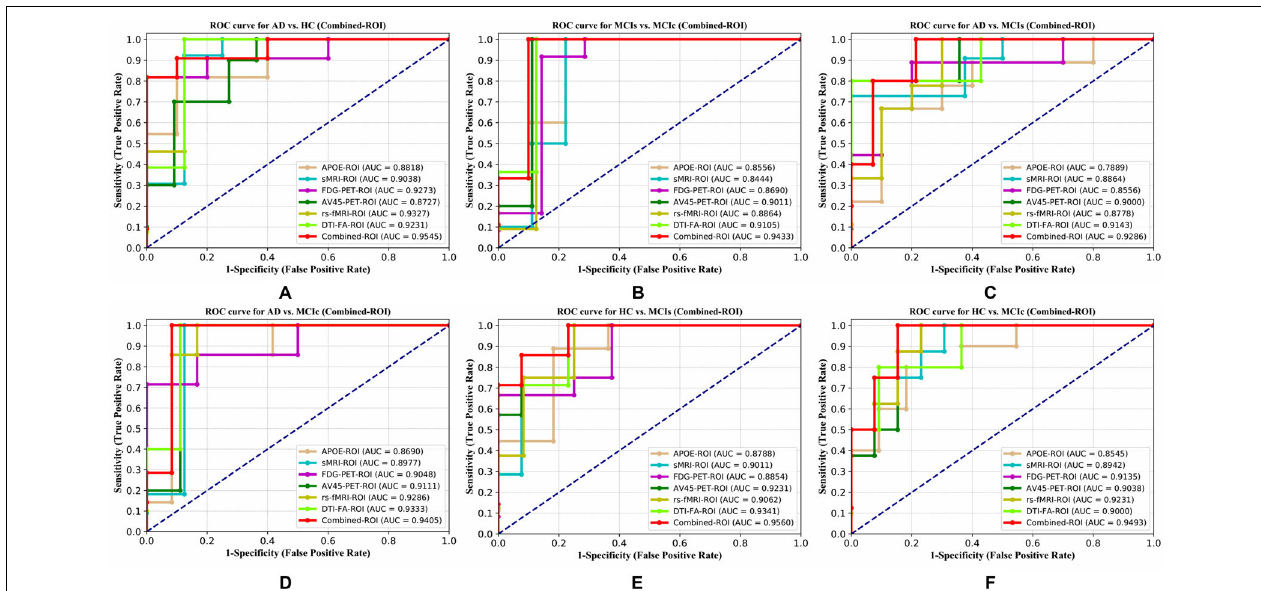
FIGURE 4 | ROC curve for (A) AD vs. HC, (B) MCIs vs. MCIc, (C) AD vs. MCIs, (D) AD vs. MCIc, (E) HC vs. MCIs, and (F) HC vs. MCIc using whole-brain parcelation analysis. The red solid line shows the result of a combined-ROI curve with single modality features.